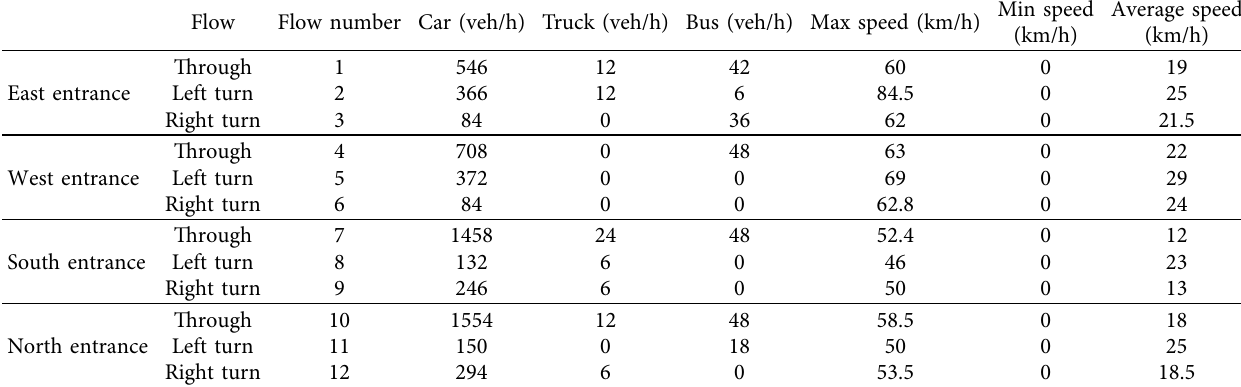
Table 1: Collected data during the peak hour of 8:00 a.m. to 9:00 a.m. on 21 October 2020. Flow